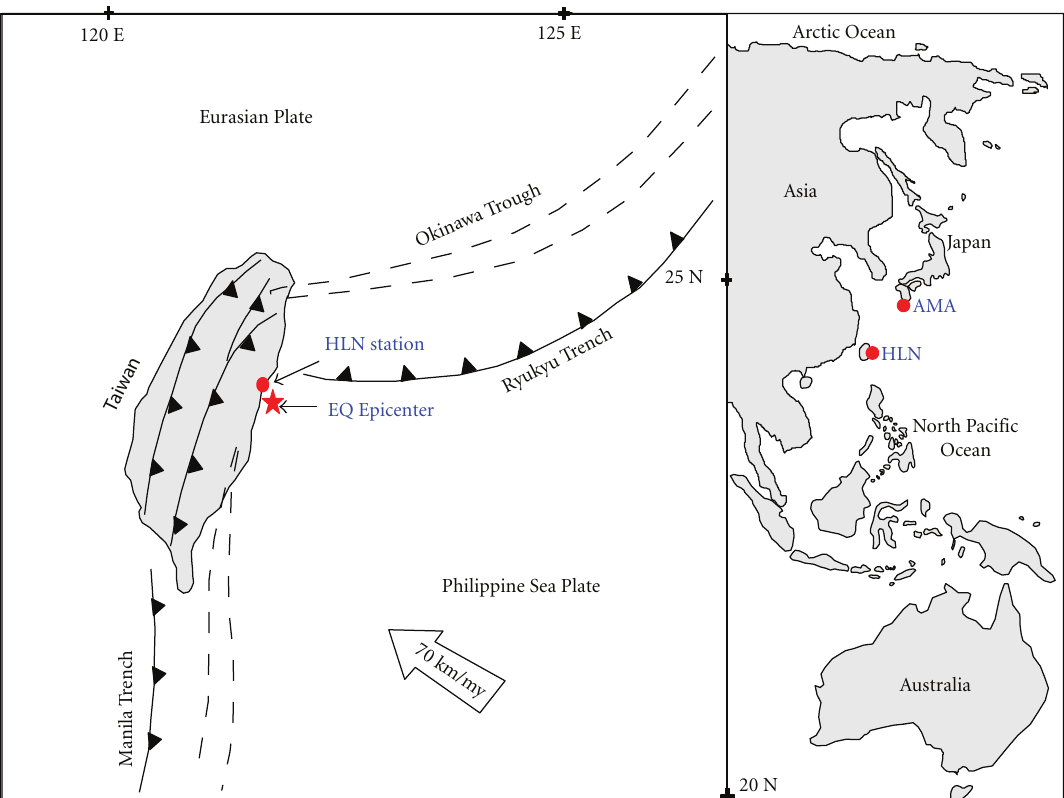
Figure 1: The plate boundaries and the tectonic elements near the Taiwan Island (after [16]) and also the locations of the HLN and AMA stations as well as the epicenter of the 19 December 2009